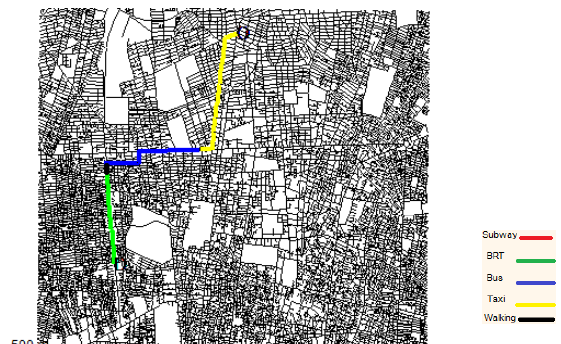
Figure 14. An example of the obtained optimal route according to the weights shown in Figure7 (Length: 6883.7 m, Time=36.4